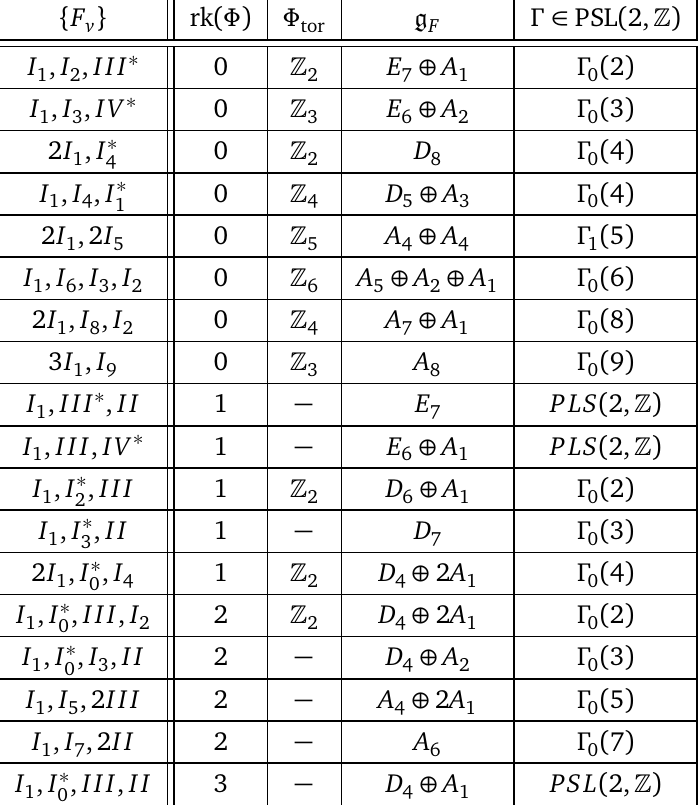
E theory that are modu- S 1 8